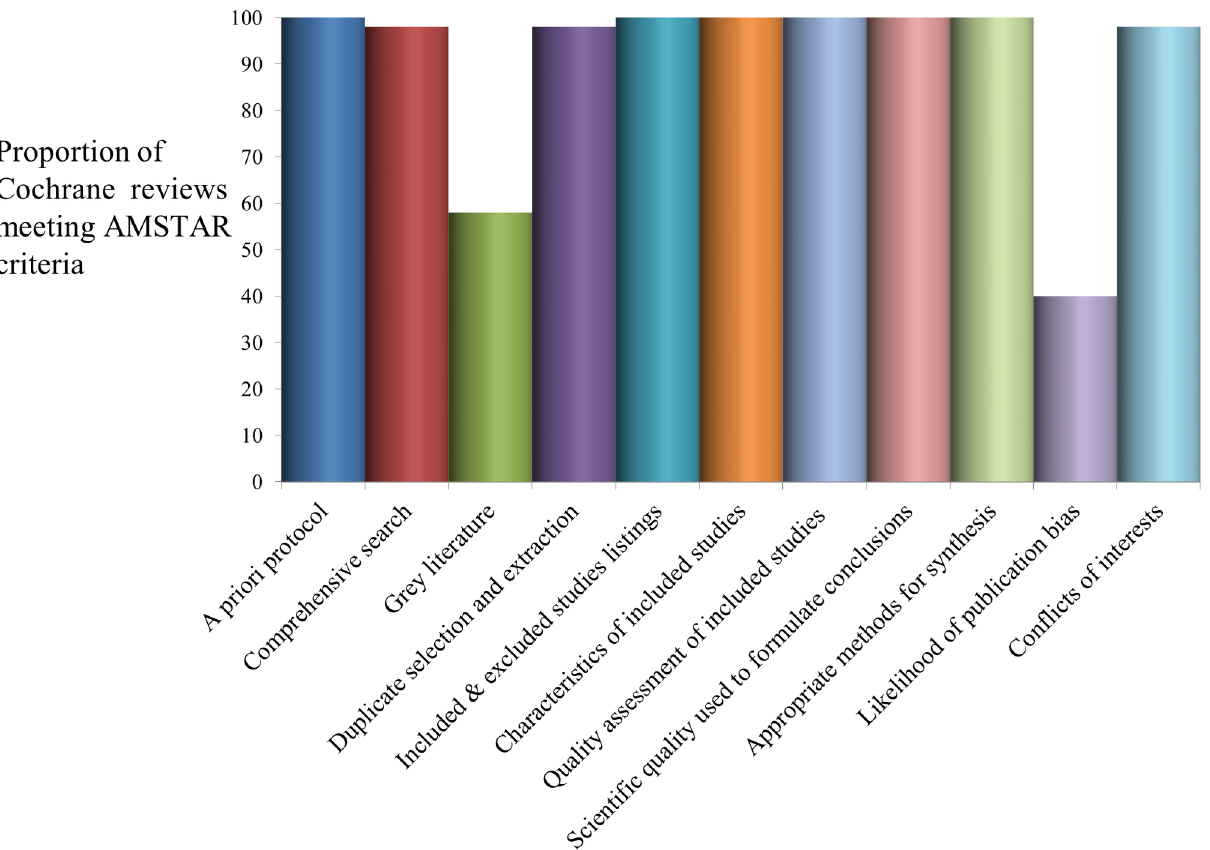
Fig 2. Quality assessment of contributing evidence from Cochrane